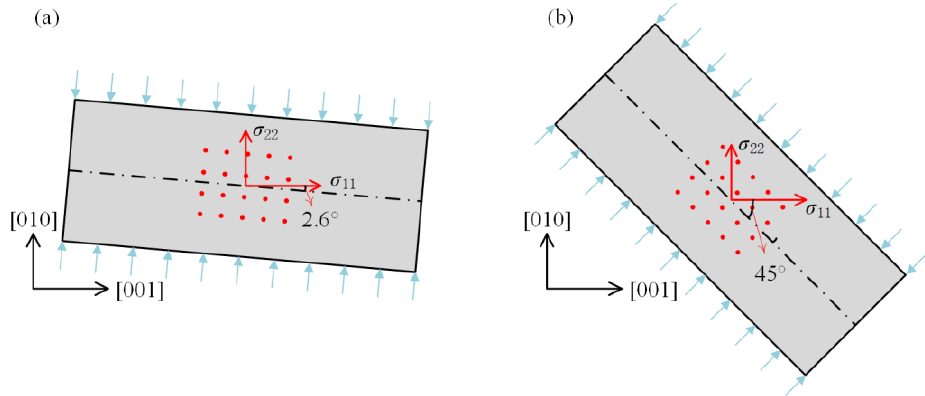
Figure 1. Schematic diagram of the sample loading method: ( a ) sample 1; ( b ) sample 2. Table 1. Stress components and principal stress sum of sample 1 and sample 2.